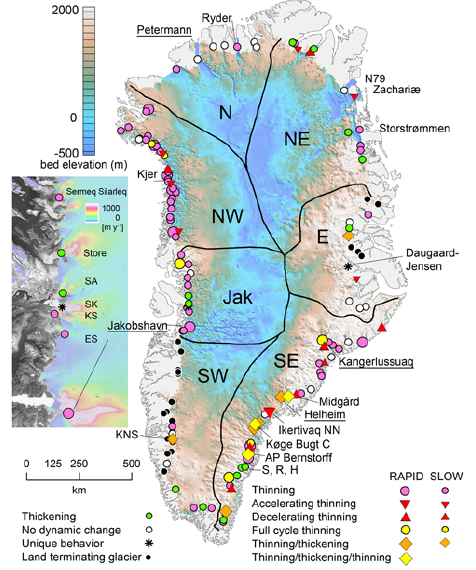
Figure 8. Distribution of different outlet glacier behavior types over a background of ice sheet bed elevation from Bamber et al., 2013. Inset shows the detailed pattern north of Jakobshavn Is- bræ overlain on ice velocities from Rignot and Mouginot, 2012. Abbreviations mark the following outlet glaciers: Sermeq Avan- narleq (SA), Sermeq Kujalleq (SK, Kangilerngata Sermia (KS, Eqip Sermia (ES), Kangiata Nunaata Sermia (KNS), Skinfaxe (S), Rimfaxe (R) and Heimdal (H) glaciers. Number in paren- thesis are ID numbers from Rignot and Mouginot, 2012. Figure is from Csatho et al.,